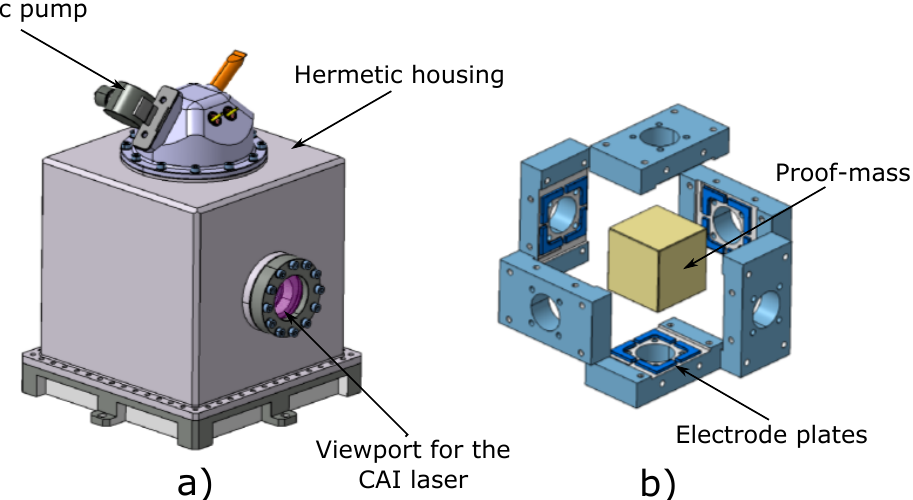
Figure 28. ( a ) HybridSTAR electrostatic accelerometer. ( b ) HybridSTAR electrode plates with the cubic